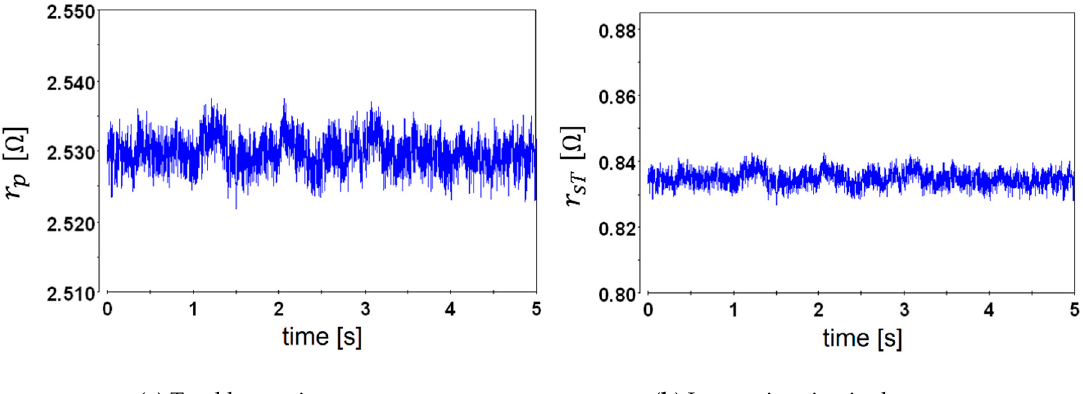
Figure 4. Experimental results of total loss estimator r p and loss estimation in the source r sT